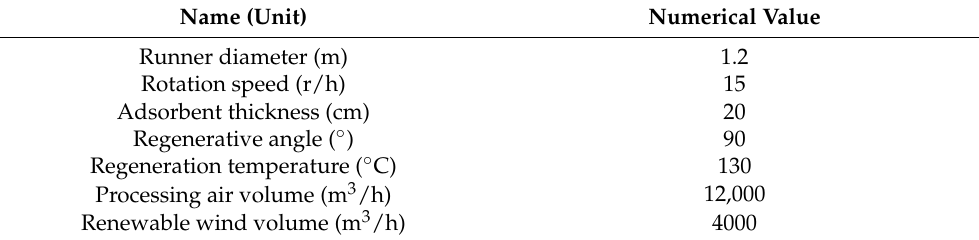
Table 2. Basic parameters of drinking water emergency extraction vehicle.